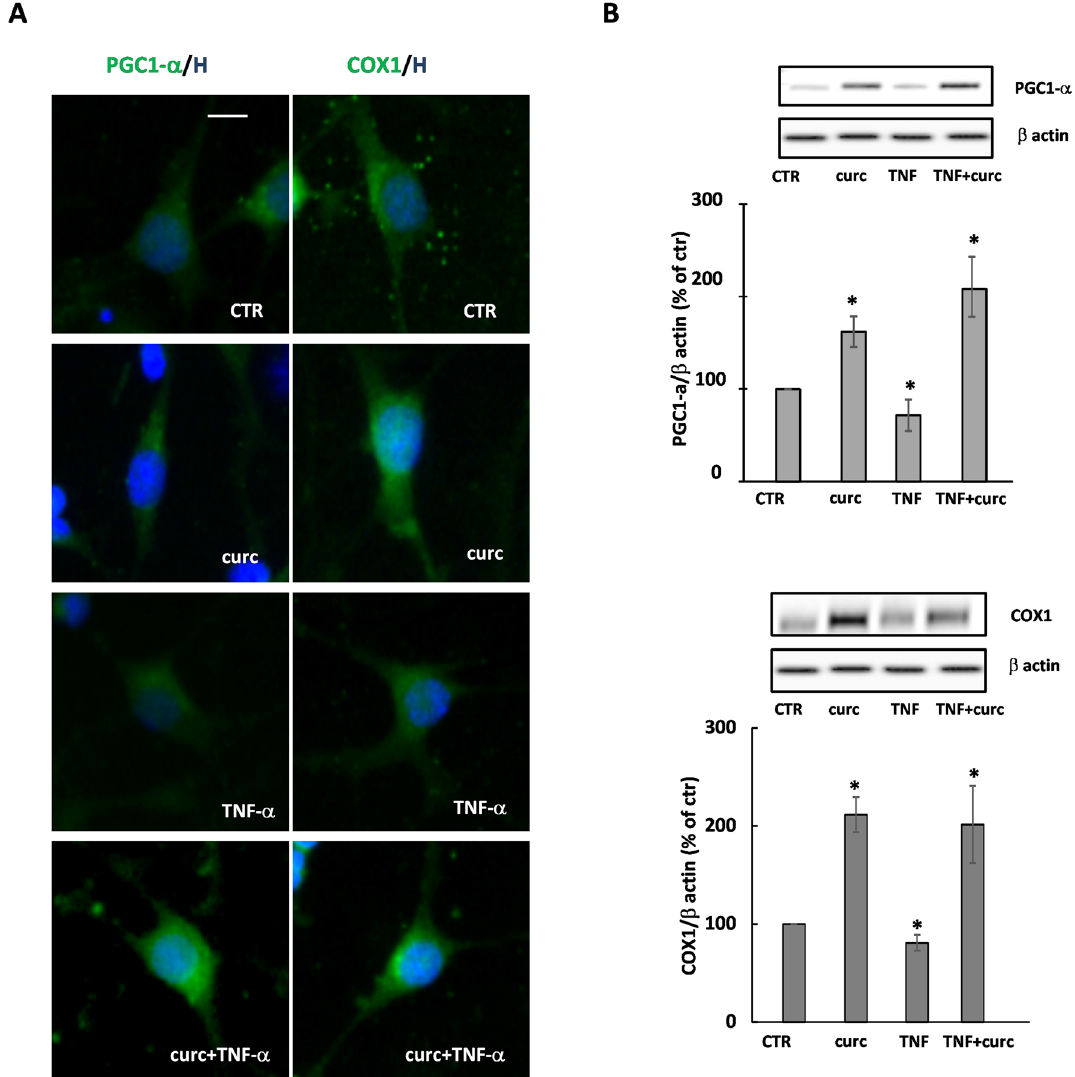
Figure 5. Curcumin protects from the effect of TNF-α on PGC1-α and COX1 expression. PGC1-α and COX1 expression levels were evaluated in cells treated for 24 h with curcumin (curc) and/or TNF-α. Representative photomicrographs are shown ( A ). Nuclei were stained using the Hoechst 33258 nuclear fluorochrome (blue, H). Representative western blot of PCG1-α or COX1 and β-actin (used as an internal control) are shown ( B ). The intensities of bands corresponding to PCG1-α or COX1 and β-actin were measured by densitometric analysis and the ratio PCG1-α/β-actin or COX1/β-actin is given as percentage on untreated cells. Data are means ± SEM of three independent experiments * p < 0.05 versus CTR, ** p < 0.005 versus curc + TNF-α. Scale bar 10 µm. Image Lab 4.0 software (Bio-Rad, http://www.bio-rad.com/en-us/sku/17096 90-image -lab-softw are) and Leica Application Suite Software (260RI, https: //www.leica -micro syste ms.com/produ cts/micro scope -softw are/detai ls/ produ ct/leica -las-x-ls/) were used respectively for Wb and IF image